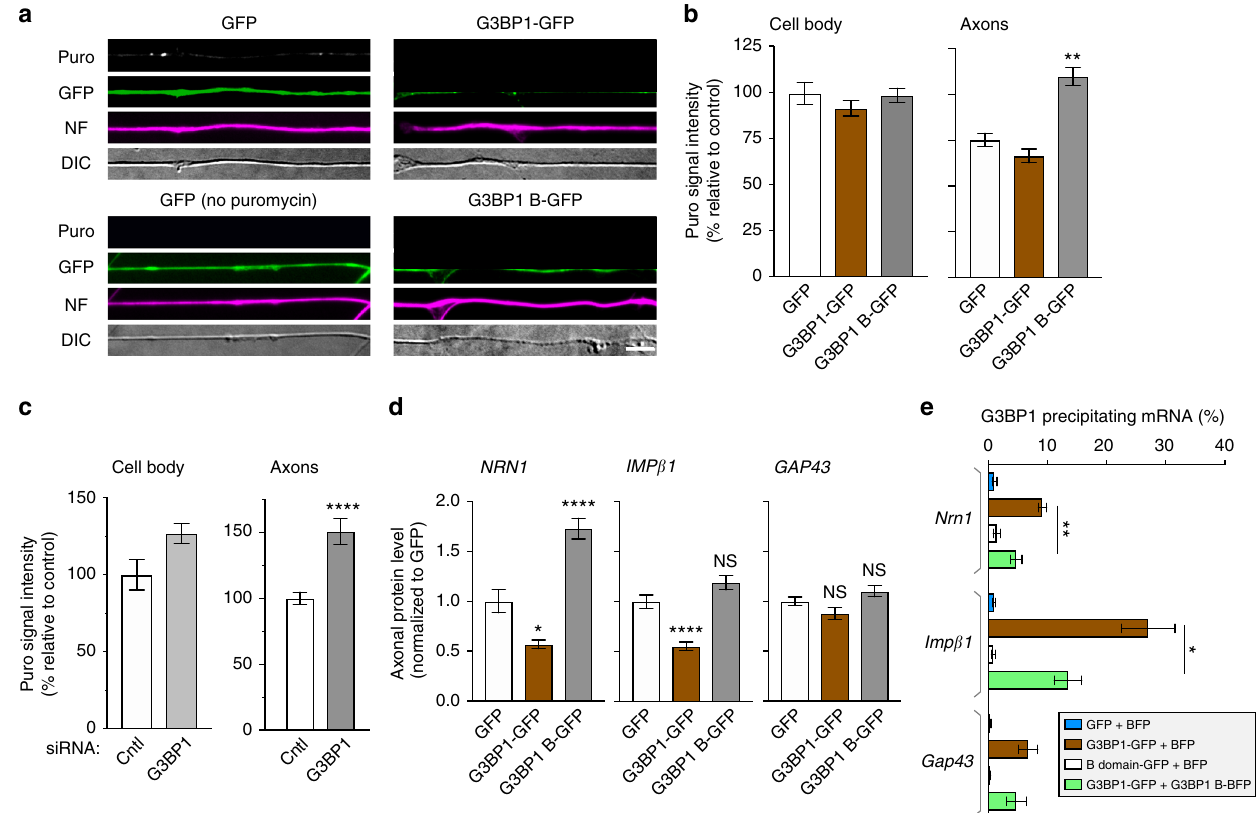
Fig. 5 G3BP1 acidic domain increases axonal mRNA translation and disassembles stress granules. a , b Representative images for puromycin (Puro) incorporation in DRG neurons transfected with the indicated constructs are shown ( a ). Signi fi cant increase in axonal puromycin signals in the G3BP1 B domain-expressing neurons is seen, with no signi fi cant change in the cell body puromycin incorporation ( b ; N ≥ 23 axons over three repetitions; ** p ≤ 0.01, **** p ≤ 0.0001 by one-way ANOVA with Tukey HSD posthoc) [scale bar = 5 μ m]. c G3BP1 depleted DRG cultures similarly show increased puromycin incorporation in axons with no signi fi cant change in cell body puromycin incorporation ( N ≥ 23 axons over three repetitions; ** p ≤ 0.01, **** p ≤ 0.0001 by one-way ANOVA with Tukey HSD posthoc). See Supplementary Fig. 7a for representative images of these puromycin incorporation studies. d Quantitation of endogenous axonal NRN1, IMP β 1, and GAP43 protein levels in DRG cultures transfected with GFP, G3BP1-GFP, and G3BP1 B domain-GFP is shown. Axonal NRN1 and IMP β 1 but not GAP43 levels are signi fi cantly reduced in G3BP1 overexpression. G3BP1 B domain-expressing neurons show signi fi cantly higher axonal NRN1, but no change in axonal IMP β 1 and GAP43 levels ( N ≥ 33 axons over three repetitions; * p ≤ 0.05, **** p ≤ 0.0001 by one-way ANOVA with Tukey HSD posthoc). Representative images for axonal immuno fl uorescence and cell body NRN1, IMP β 1, and GAP43 proteins are shown in Supplementary Fig. 7b, c. e RTddPCR for axonal mRNAs co-precipitating with G3BP1-GFP in DRG neurons are shown as average % mRNA associated with G3BP1-GFP± SEM. Nrn1 and Imp β 1 mRNAs association with G3BP1-GFP signi fi cantly reduced by cotransfection with the G3BP1 B domain, but neither RNA coprecipitates with the B domain ( N = 4 culture preparations; * p ≤ 0.05, ** p ≤ 0.01 by Student ’ s t -test for the indicated data